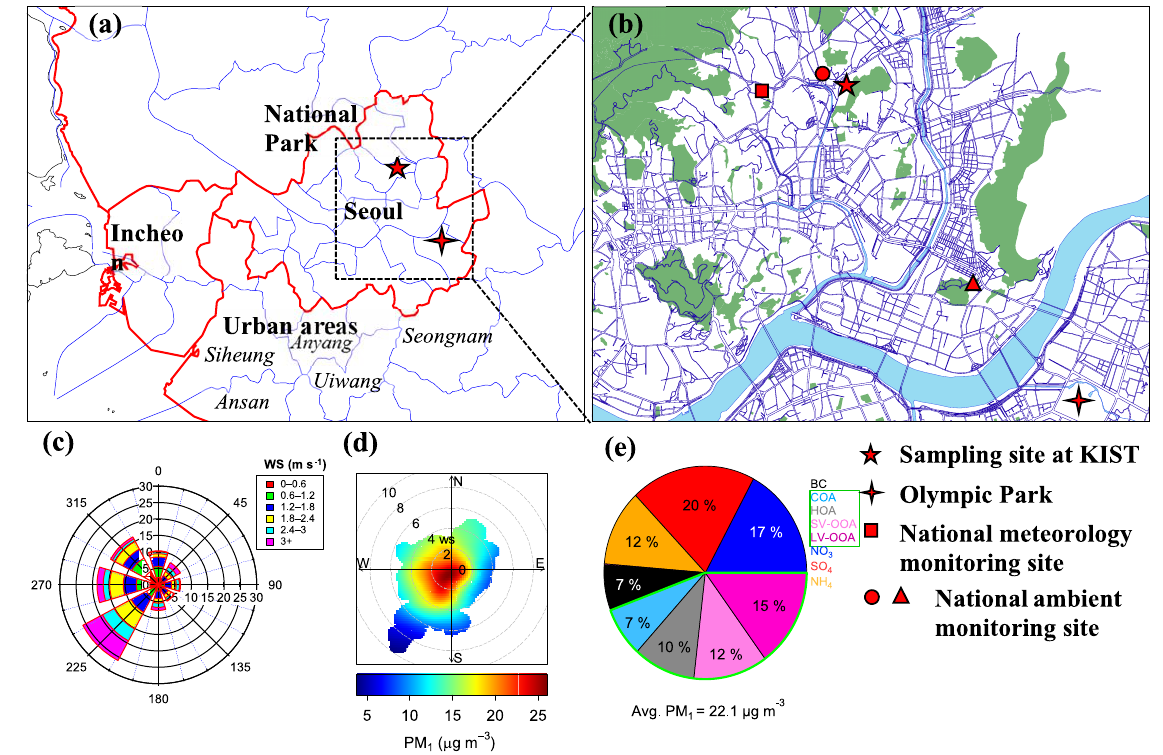
Figure 1. (a) The map of SMA and surrounded by other nearby cities including Incheon where industrial facilities are located (west and south), agricultural and biogenic areas (east and south) and Bukhansan National Park (north); (b) the location of the sampling site in Seoul which is in the north-east of the city center and north of the Han River. Also shown is the other supersite located at Olympic Park. Blue lines shown in the figure indicate roadways; (c) wind rose plot for the entire study period; (d) bivariate polar plots of PM 1 (non-refractory PM 1 plus black carbon (BC)) concentrations (in µgm − 3 ); (e) average compositional pie chart of PM 1 species and each of the OA factors over the whole campaign. The green outline indicates the fraction of total